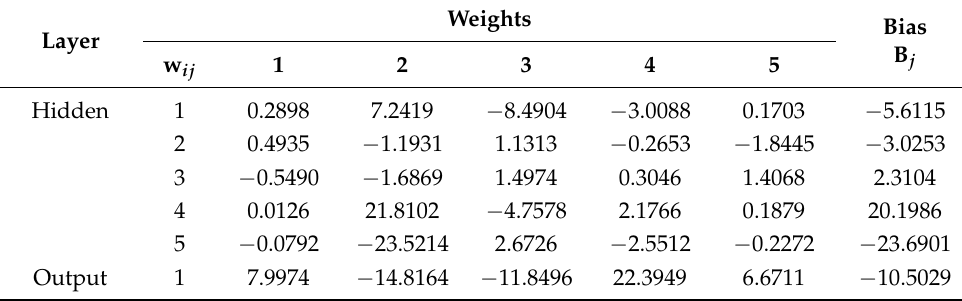
Table 6. Weights and biases for R 3.2 model of unaged binders.